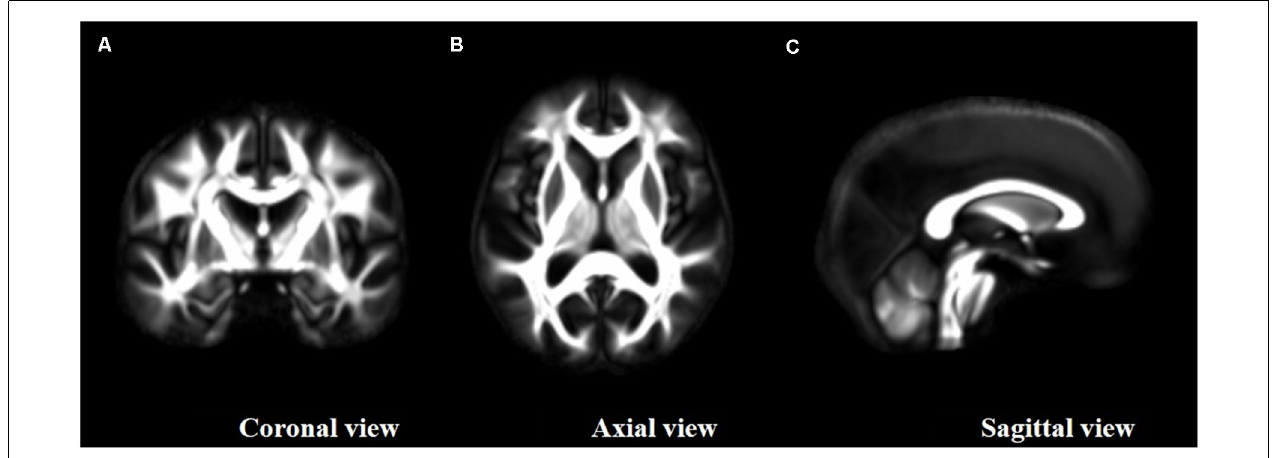
corresponding skeletonized MD between the first and